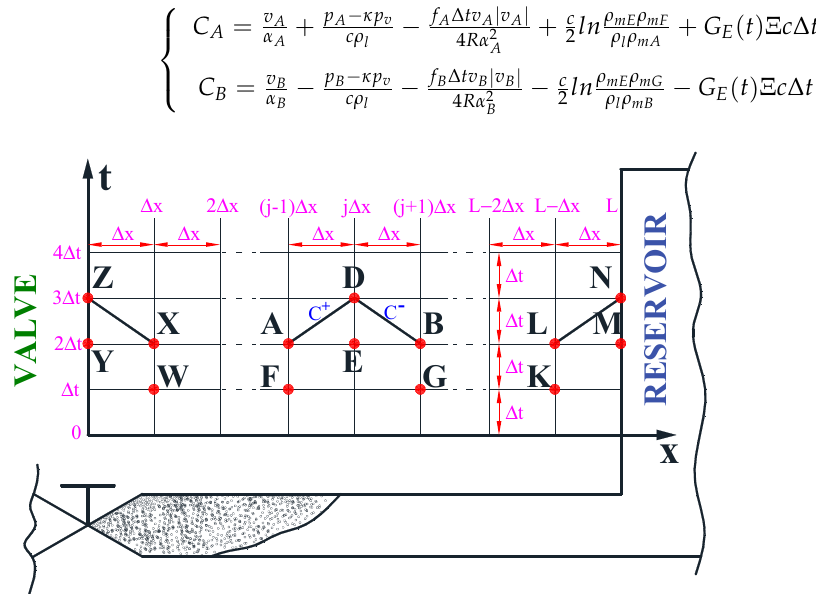
Figure 1. Rectangular grid in the method of characteristics.